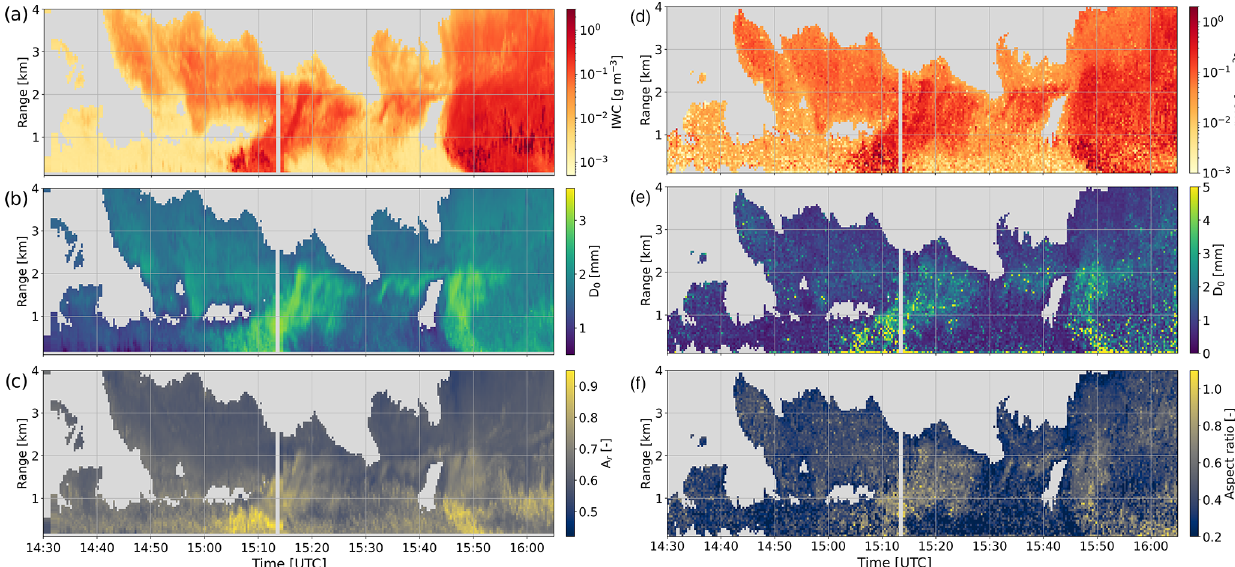
Figure C1. Comparison of time series for three examples of variables (IWC, D 0 , and A r ) retrieved through the proposed framework (a–c) or a direct deep-learning retrieval (d–f) . Note that the color bars may differ (adjusted to reflect at best the variability in each field).